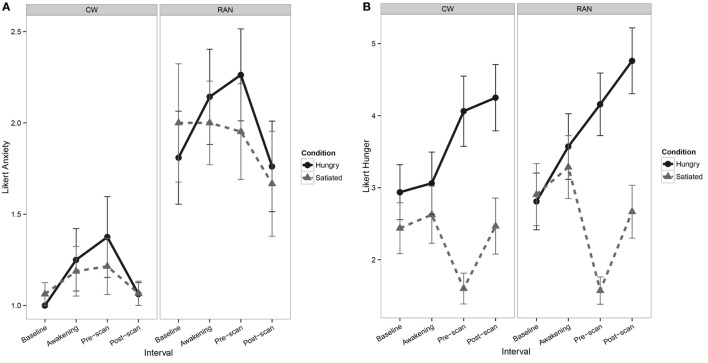
Line graphs depicting self-report Likert-type visual analog scale values. (A) Line graph of pre- and post-scan self-report measures of current anxiety show a main effect of Group [F(1,35) = 8.1, p = 0.007], with RAN reporting greater anxiety relative to CW [z = 2.56, p = 0.010] and interval [F(1,100) = 6.6, p = 0.011], although post hocs were not statistically significant. No main effect of Visit or any interactions of Group, Visit, and Interval were found. (B) Line graphs of pre- and post-scan self-report measures of hunger show a main effect of Visit [F(1,35) = 138.1, p = < 0.001], with participants reporting greater hunger in the Hungry condition relative to the Satiated condition [z = 6.04, p < 0.001], and a main effect of Interval [F(1,101) = 12.8, p < 0.001], although post hocs were not statistically significant. No main effect of Group or any interactions of Group, Visit, and Interval were found. CW, healthy comparison women; RAN, women remitted from anorexia nervosa.